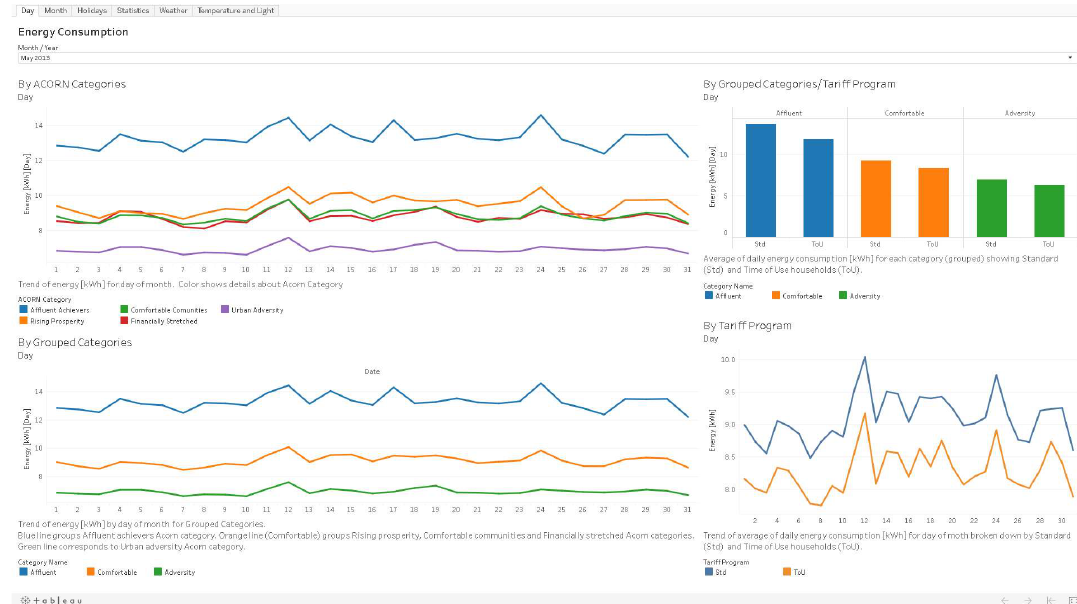
Figure 6. Descriptive analytics dashboard—Day of the month.In this way, information with different temporal granularities (hour, day, month), different household groups (acorn or grouped categories, Std or ToU households), analysis for specific events (holidays vs. business days), correlations with external variables (temperature, humidity, light hours), and comparisons with other types of results (groups assigned by the clustering algorithm and electricity consumption forecasting) were made available.